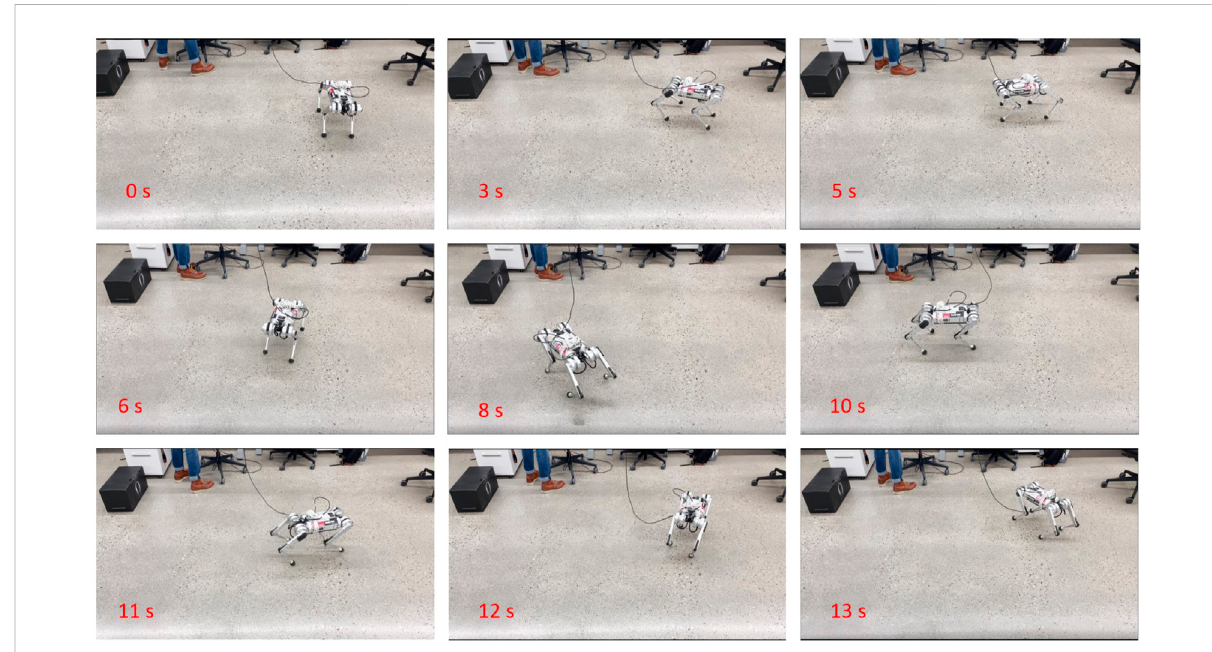
FIGURE 11 Snapshots of the experiments on reference tracking in Mini Cheetah trotting. The time corresponds to the reference signal in Figure 12.